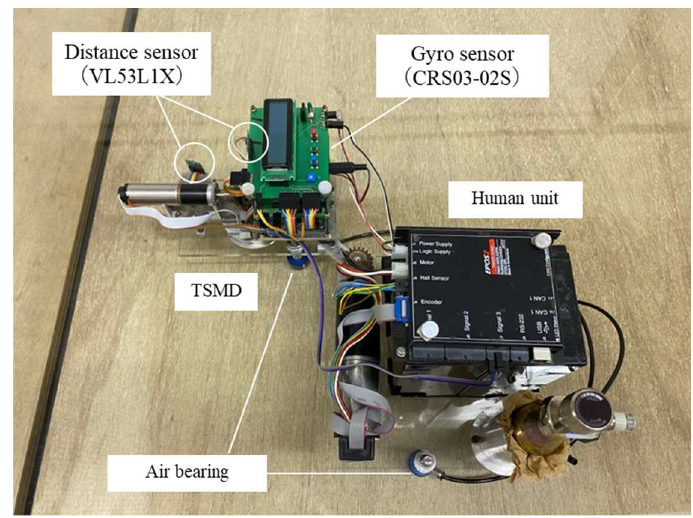
Figure 4. Experimental setup of TSMD.